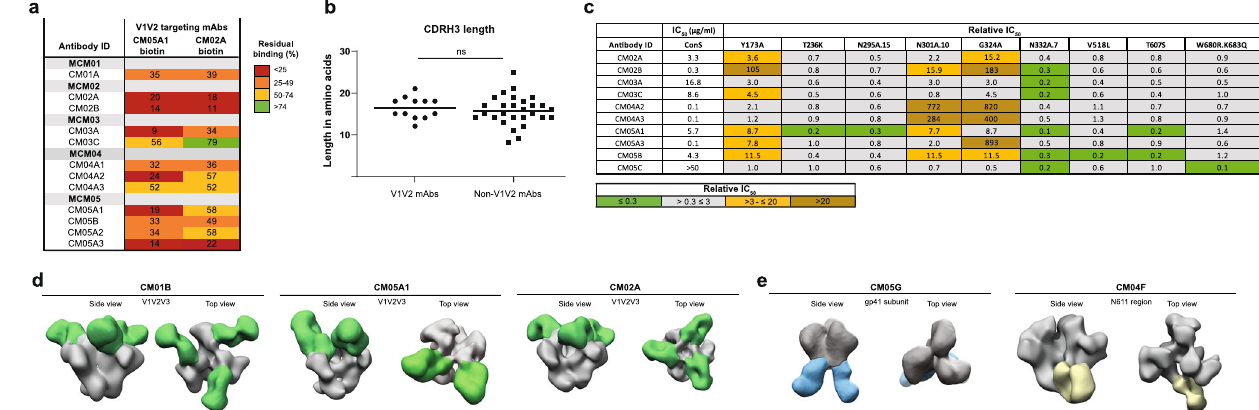
Fig. 4 Epitope speci fi cation of V1V2 region and gp41 targeting NAbs. a Percentage of residual binding of suspected V1V2 targeting NAbs to ConM SOSIP.v7 trimers in presence of a competing biotinylated V1V2 targeting mAb (CM05A1, CM02A). V1V2 targeting mAbs were classi fi ed as mAbs that showed competition (<60% residual binding) with either of the two competitor mAbs. b Individual CDRH3 amino acid lengths of the V1V2 region targeting and non-V1V2 region targeting isolated mAbs. Two-tailed unpaired t-test was used to determine statistical differences ( p = 0.2714). c Neutralizing activity of 10 NAbs with varying epitopes was measured against a panel of ConS virus mutants. For each mAb, the fold-change of the IC 50 value against each pseudovirus variant relative to the ConS parental virus is given. This value is indicated as the relative inhibitory concentration 50 (RIC 50 ). d Negative stain-electron microscopy (NS-EM) was performed on a selection of mAbs to verify various epitope speci fi cities. NS-EM con fi rmed the binding of CM01B, CM05A1, and CM02A to a region surrounding the V1V2V3 epitope. mAbs are complexed with ConM SOSIP.v9.0 protein. e NS-EM con fi rmed the binding of several NAbs to the gp41 Env subunit, of which CM05G is an example. CM04F also binds the gp41 Env subunit, in a region proximal to the N611 PNGS. mAbs are complexed with ConM SOSIP.v9.0